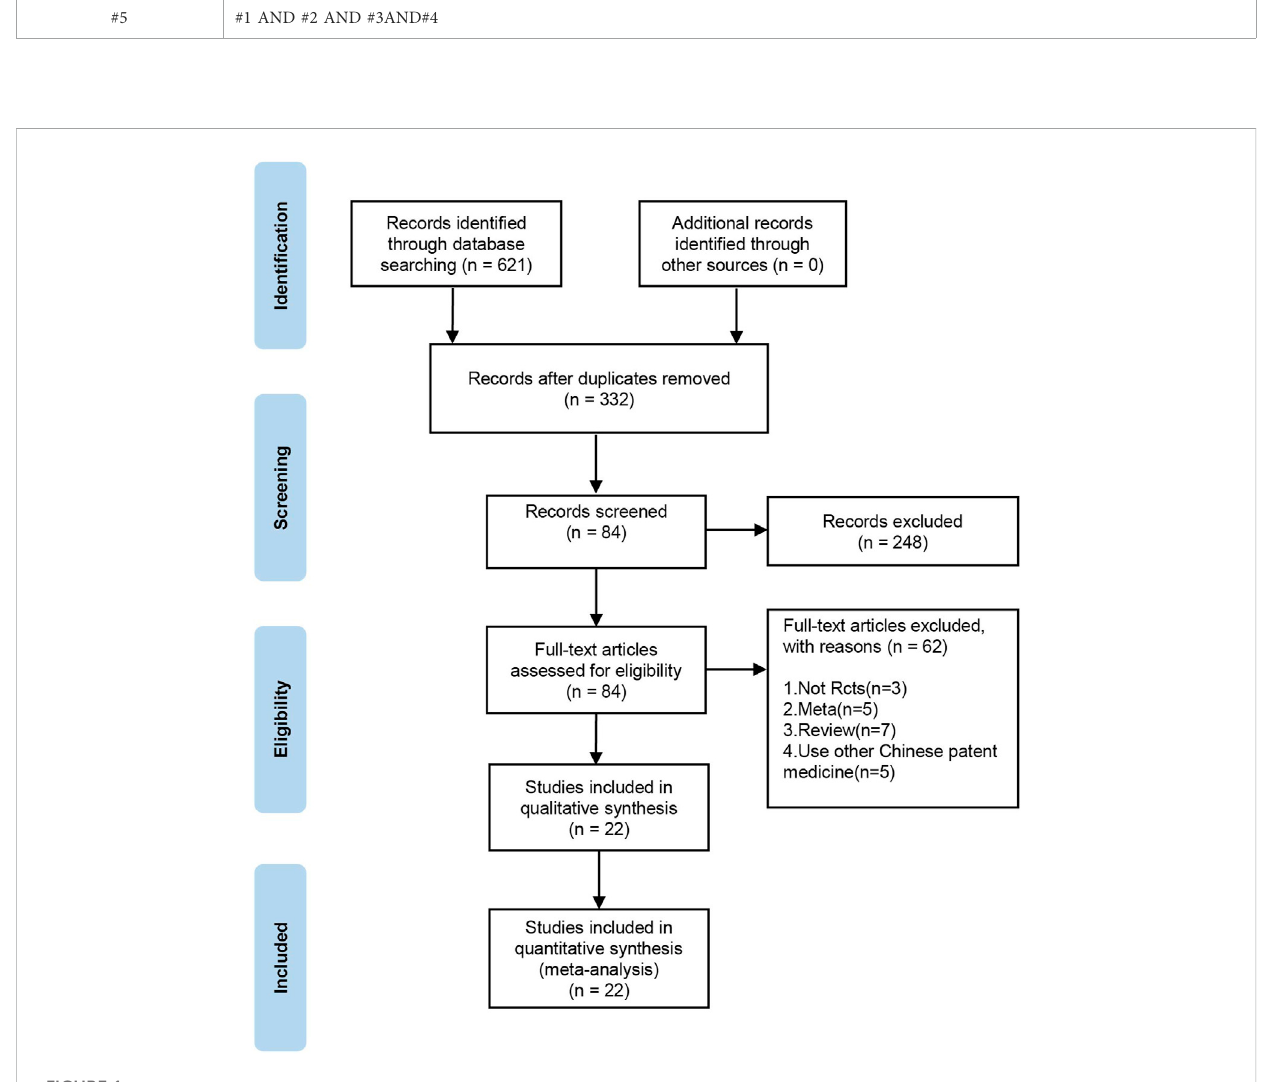
FIGURE 1 Flow diagram of the literature screening and selection